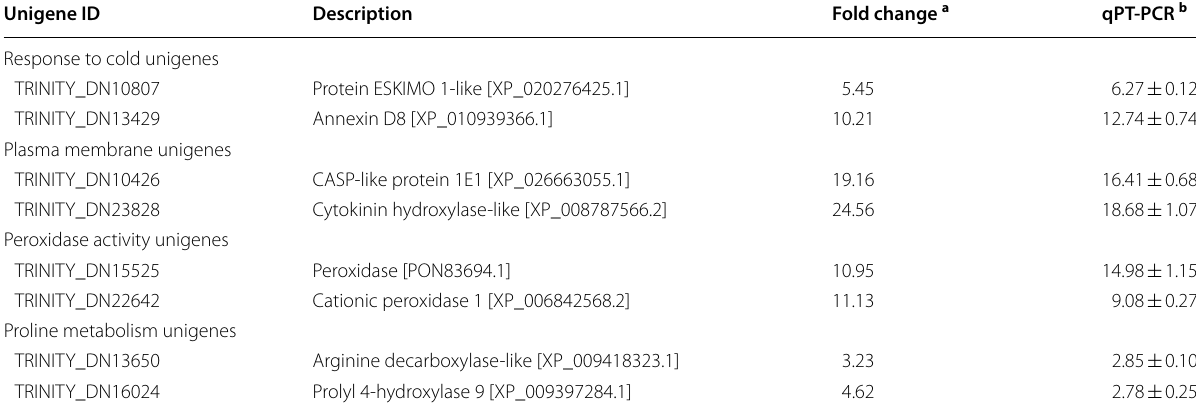
a Foldchange, ratio(S1/S2). S1, the FPKM value of a unigene under Put treatment; S2, the FPKM value of a unigene in control group b qRT-PCR, relative transcription level of unigenes under Put treatment measured by qRT-PCR compared to that of control group